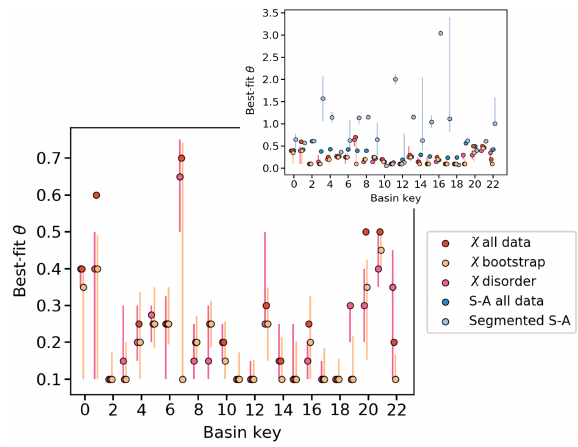
Figure 12. The predicted best-fit θ determined using the χ methods (red points) and slope–area methods (blue points shown in inset). Basin numbers correspond to those plotted in Fig.